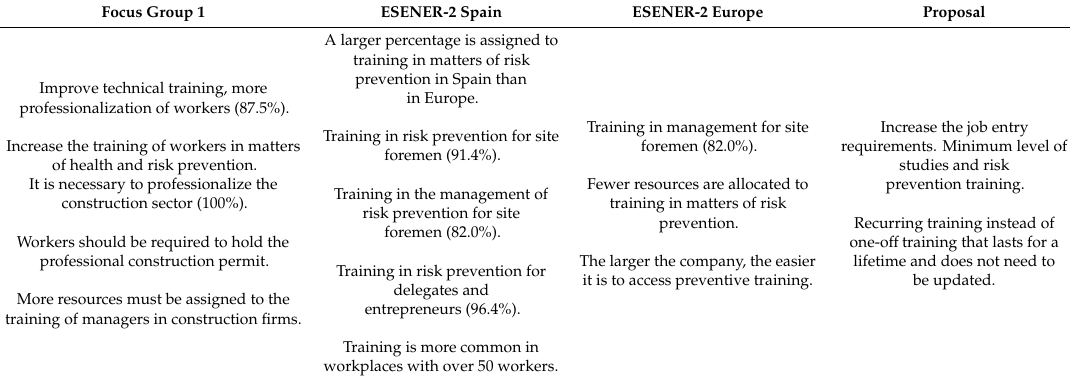
Table 5. Conclusions drawn from focus group 1 and the Second European Survey of Enterprises on New and Emerging Risks (ESENER-2, in both its Spanish and European versions), referring to the second indicator (quality of training of personnel linked to the construction companies) used as a guide in discussion groups. Source: [61,62]. Focus Group 1 ESENER-2 Spain ESENER-2 Europe